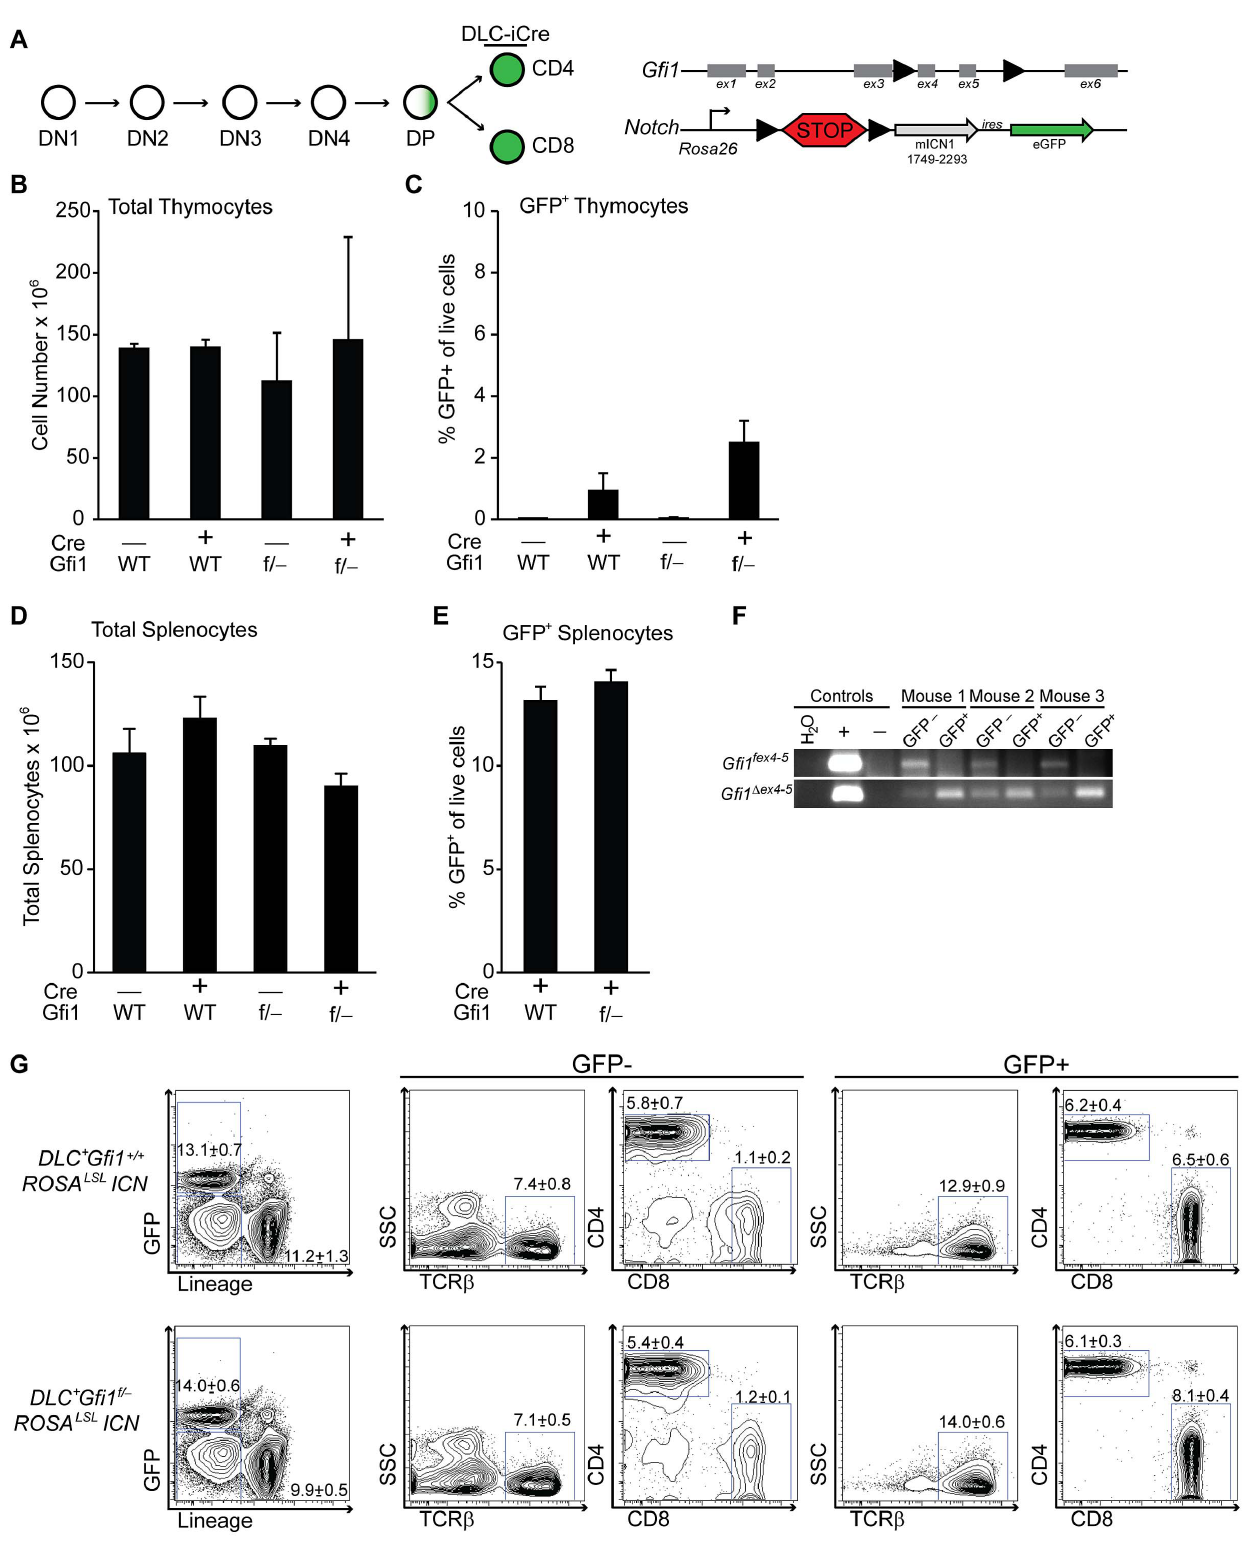
Figure 2. Peripheral T cells do not require Gfi1 for Notch activation. (A) Top left: Schematic of T cell development demonstrating the distal Lck-driven Cre (DLC-iCre) activity is off during most stages of T cell development, but activates in single-positive cells. Top right: Schematic of the floxed Gfi1 locus as well as the ICN transgene which has a floxed ‘‘STOP’’ cassette (lsl) preventing activation of ICN and GFP. (B–C) Total thymocyte numbers (B) and percentage of live, GFP-expressing thymocytes (C) as determined by flow cytometric analysis of Gfi1 + / + ROSA LSL ICN (n=4), DLC- iCre + Gfi1 + / + ROSA LSL ICN (n=2), Gfi1 f/ 2 ROSA LSL ICN (n=2), and DLC-iCre + Gfi1 f/ 2 ROSA LSL ICN (n=4) mice. Averages with SD are shown (B–C). (D) Total splenocyte numbers of Gfi1 + / + ROSA LSL ICN (n=8), DLC-iCre + Gfi1 + / + ROSA LSL ICN (n=10), Gfi1 f/ 2 ROSA LSL ICN (n=5), and DLC-iCre + Gfi1 f/ 2 ROSA LSL ICN